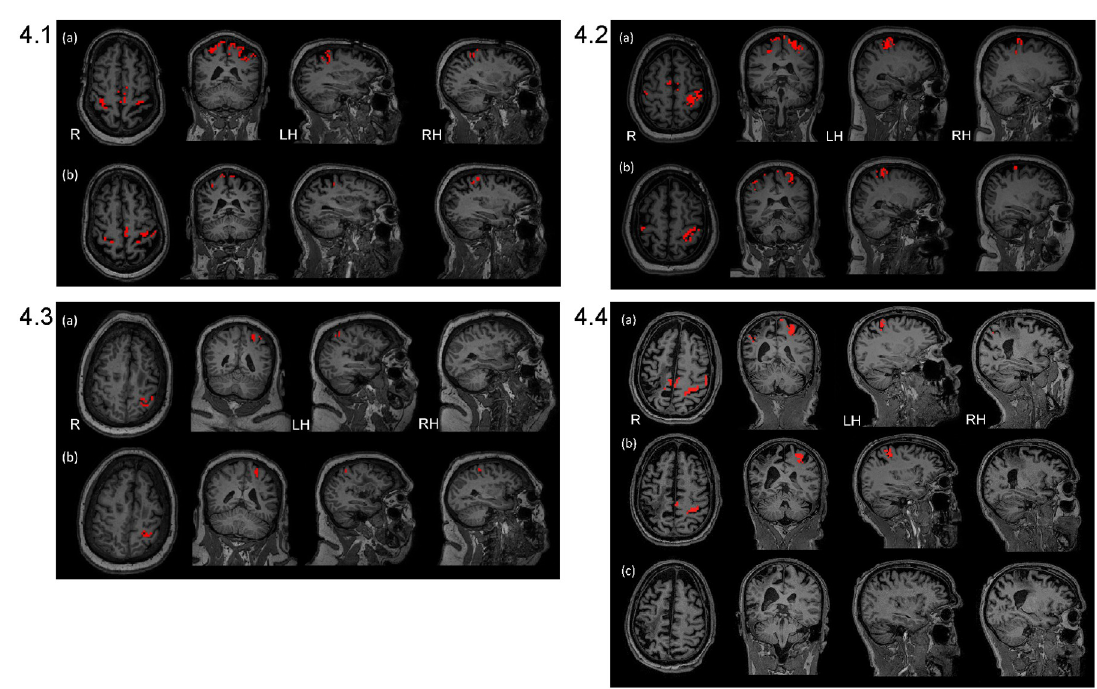
Fig 4. Brain map outcome measures acquired at pre-treatment and follow-up. Brain maps are shown for right and left hemisphere regions: HK, BA4—HK, BA3, and BA6) reflecting the summary results in Table 3 above for pre-treatment and follow-up. (FWEc, p value = 0.05 with small volume correction, used for thresholding each ROI). Key: R = right hemisphere; LH = left hemisphere; RH = right hemisphere. Individual activation values are in the S1 File, Section I. Outcome Measures, Section 1.2. fMRI Outcome Measures, Individual Subject Data; Table 2a-2d in S1 File. 4.1. Subject 1. S1 in S1 File showed lessening of activation from pre-treatment to follow-up in all ROIs. 4.2. Subject 2. S2 in S1 File showed lessening of activation in all ROIs from pre-treatment to follow-up, except for right sensory region which remained consistent. 4.3. Subject 3. S3 in S1 File showed increases in all left lesioned hemisphere ROIs, except sensory which decreased minimally; there was an increase in right Primary Motor-Hand Knob and all other ROIs remained consistent or with only minimal change. 4.4. Subject 4. S4 in S1 File. For S4 in S1 File, from pre-treatment to post-treatment in the right lesioned hemisphere, there was a 26% decrease for the sensory region, with zero or near zero for the remaining right ROIs. For the left hemisphere, there was a decrease in all ROIs, except for a minimal increase in the Hand Knob